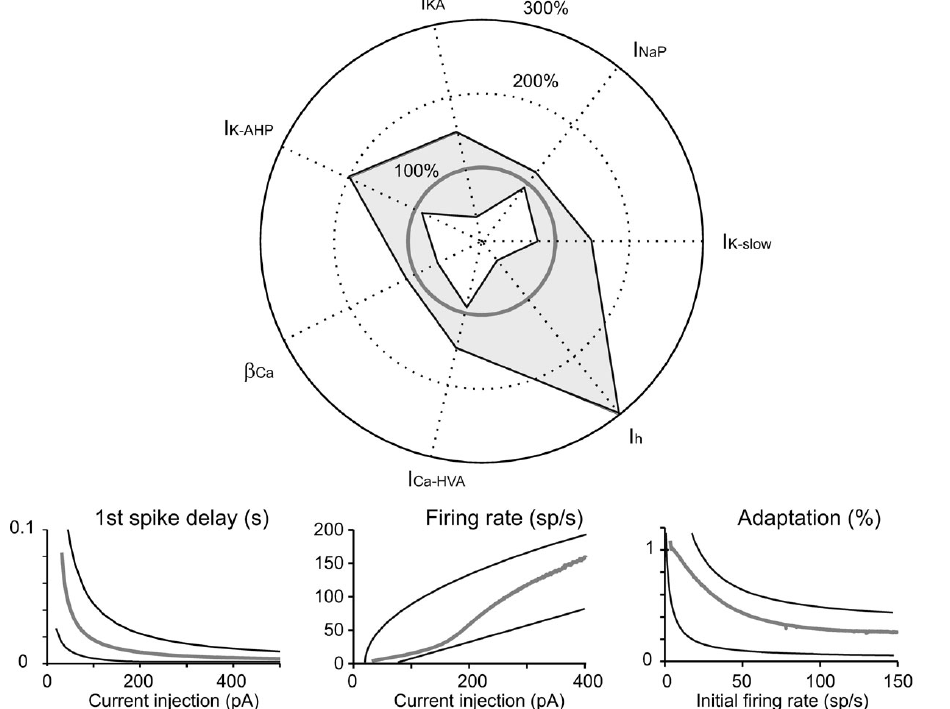
Figure 8. Robustness of the model . Tests of robustness of the model against changes in individual parameters. Polar plot: The maximum conductance of I K-slow , I Na-p , I KA , I K-AHP , I Ca-HVA , and I h , as well as b Ca , were modified in turn. The changes covered (in 30 steps) the range from total block (center of the polar plot) to threefold increase (outer solid circle) in the canonical model value (thick gray line). Model simulations were obtained using the protocols described in Figures 2– 4 . The thin black lines delimiting the light gray area show the minimum and maximum parameter changes (percentage of canonical model values), which maintained the model within the boundaries of Golgi cell characteristic response. Lower panels: Results were considered to conform to Golgi cell behavior on the base of five criteria. (i) The pacemaker frequency had to fall in the range 0.5–9Hz. (ii) The first spike latency triggered by the rebound excitation had to fall in the range 30–100ms. (iii–v) The response to current injection had to show first spike latency, initial firing rate, and spike frequency adaptation within the boundaries reported in the panels. Thin black lines are boundaries derived from the envelope of data points in Figure 4B and the thick gray line shows the canonical model behavior